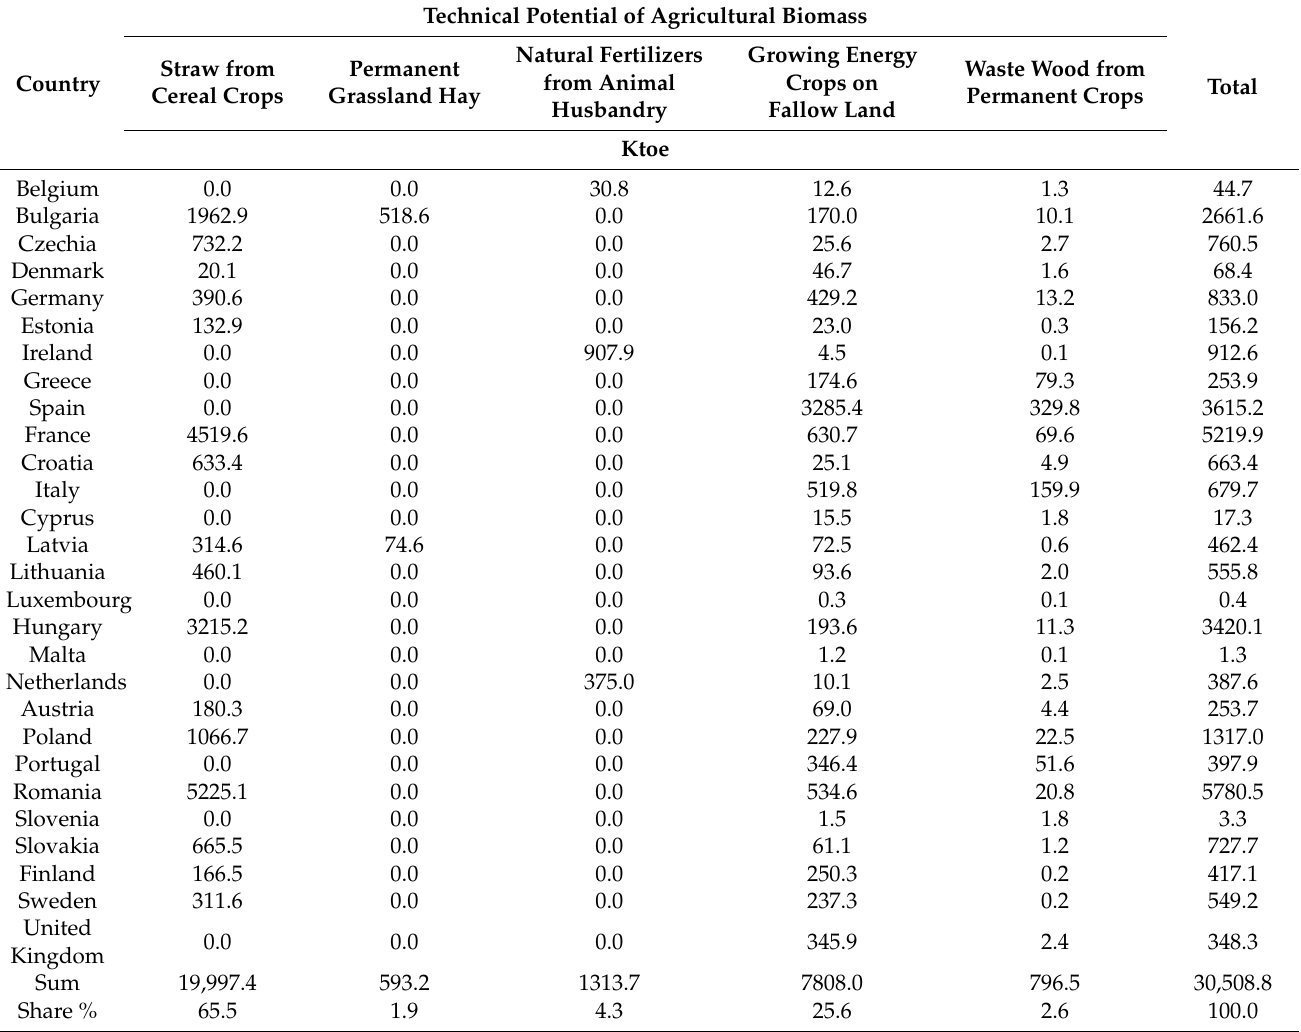
Table 3. Technical potential of agricultural biomass in EU countries in